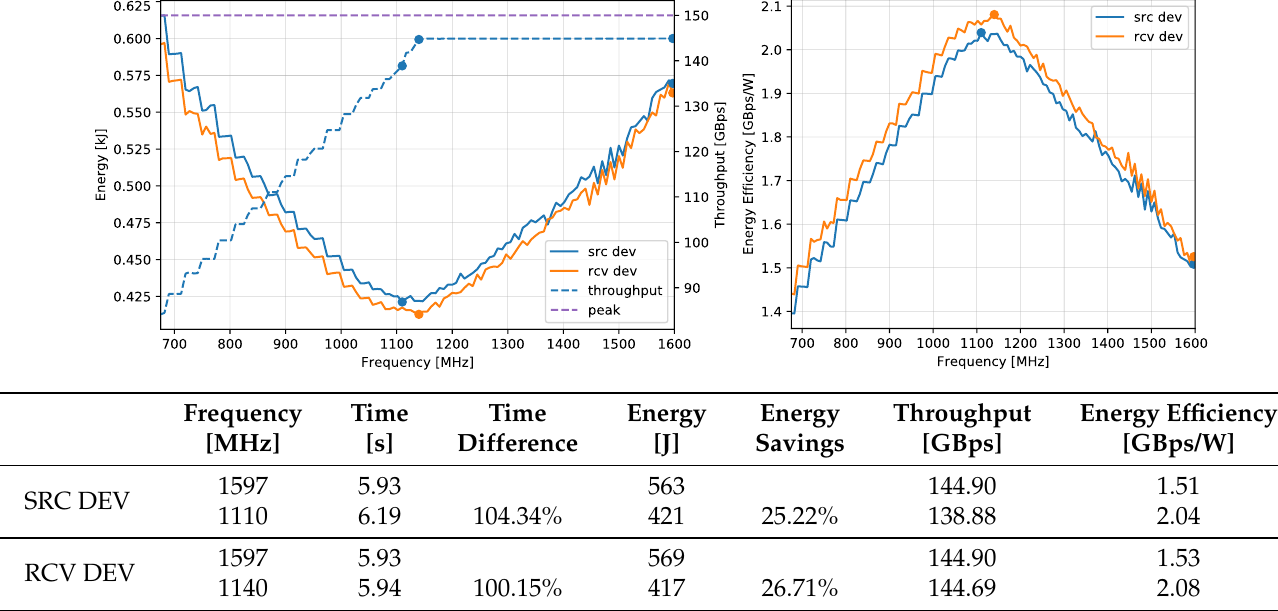
Figure 12. DGX-2 Frequency scaling of the NVLink P2P transfer benchmark. The plot on the left shows consumed energy and throughput. The plot on the right shows the energy efficiency. The table shows the time difference, energy savings, and energy efficiency of the NVLink transfer at the base and at the optimal frequency. The marker in the plot highlights the two frequencies from the